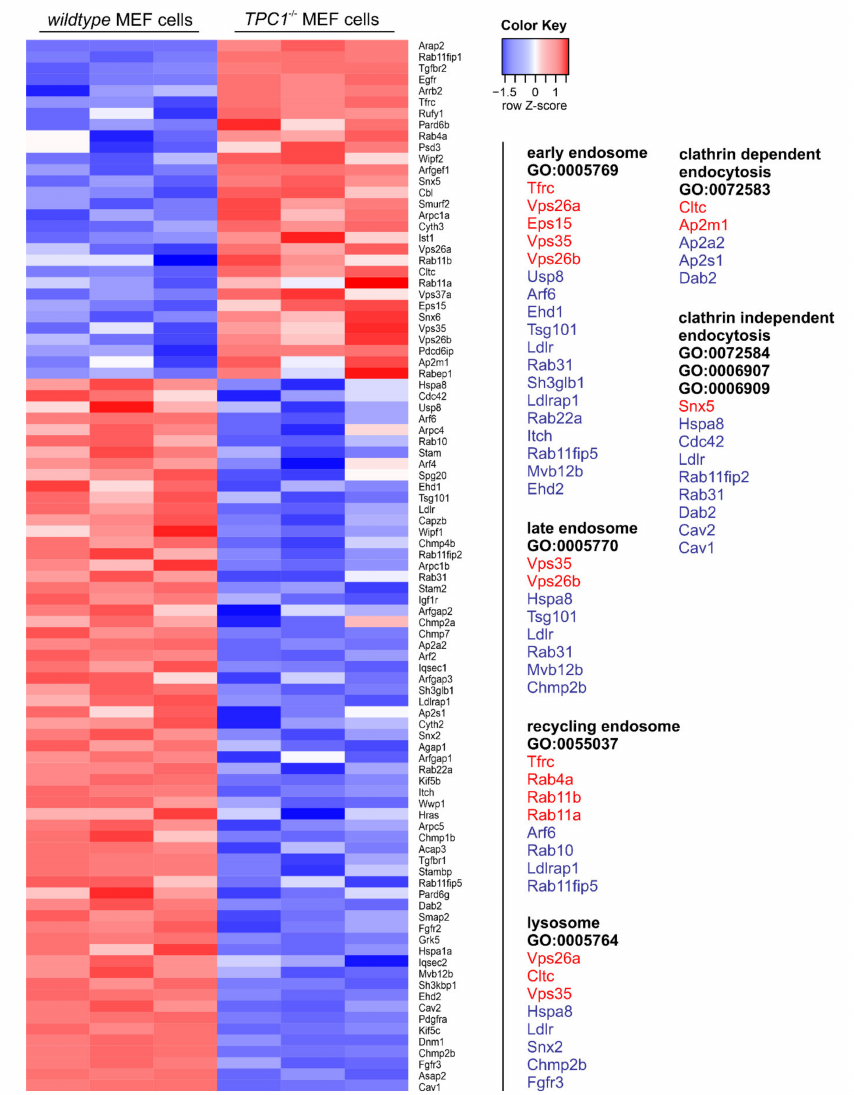
Figure 5. Heatmap of genes involved in endocytosis. Heatmap showing significantly differentially expressed genes (q < 0.05) in TPC1 deficient MEF vs. wildtype cells that are involved in endocytosis (KEGG pathway 04144; [49]. Expression values are shown as Z-scores of the log2 transformed normalized counts for each gene. Each column stands for one independent sample of the depicted genotype ( n = 3). Red and blue are assigned to a higher and a lower expression, respectively, according to the color key in the upper right. Heatmap was created using tools integrated in the Galaxy platform [46]. All genes listed were compared to GO terms shown on the right. Only genes that were significantly changed were included and categorized according to the endolysosomal compartment or to the nature of endocytosis. Same color code was used as in heatmap. Original sequencing data were deposited in the Short Read Archive at the National Center for Biotechnology Information (NCBI) under the BioProject ID